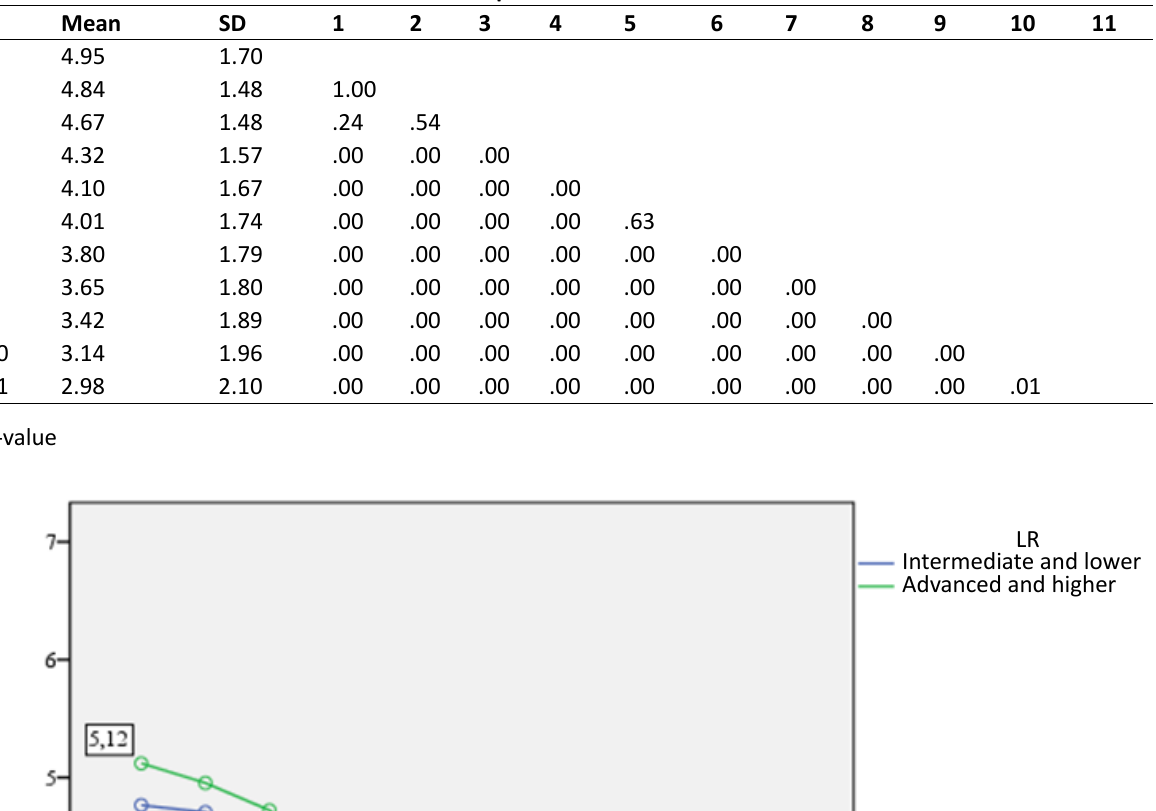
Table 2. ANOVA comparisons of visual quality perceptions of participants about chalk effect Variables